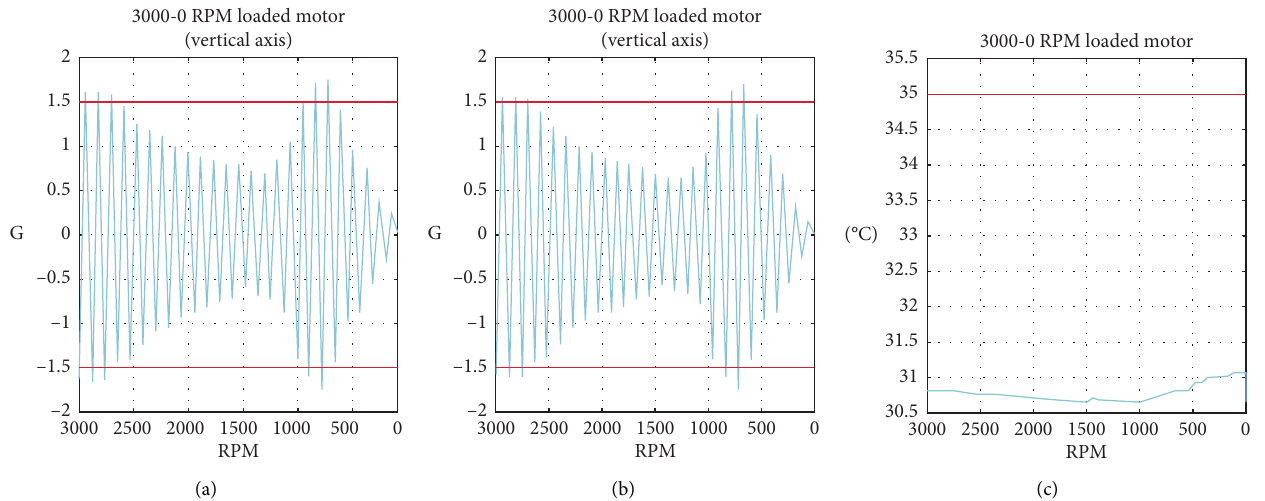
Figure 8: The 3000–0 RPM measurement-speed graph of the loaded motor: (a) vertical axis, (b) horizontal axis, and (c) temperature-speed graph of the loaded